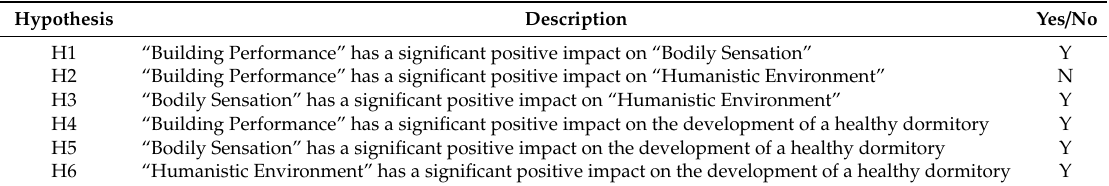
Table 6. Verified results of the proposed